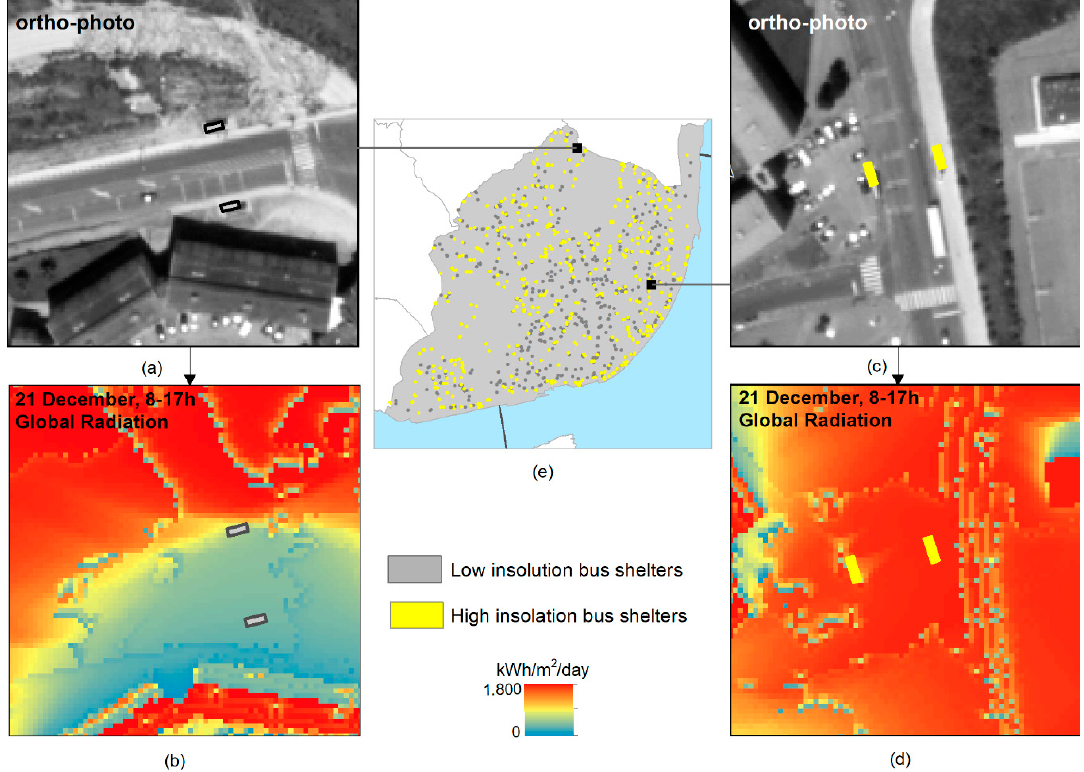
Figure 8. Low ( a , b ) and high ( c , d ) insolation bus shelters’ spatial distribution in Lisbon ( e